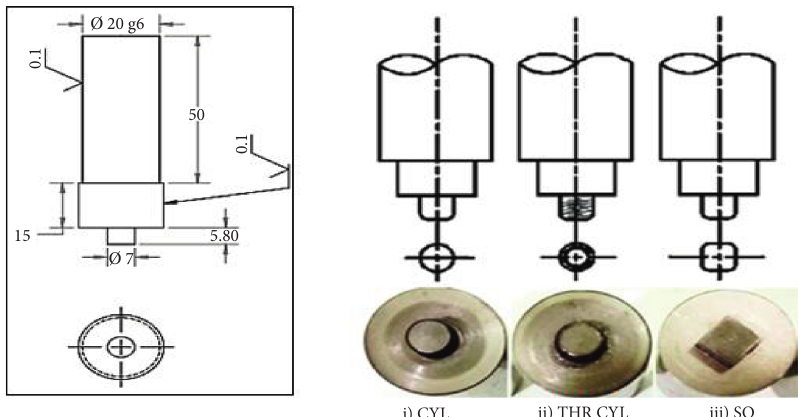
Figure 4: Schematic and photographic views of tool pin